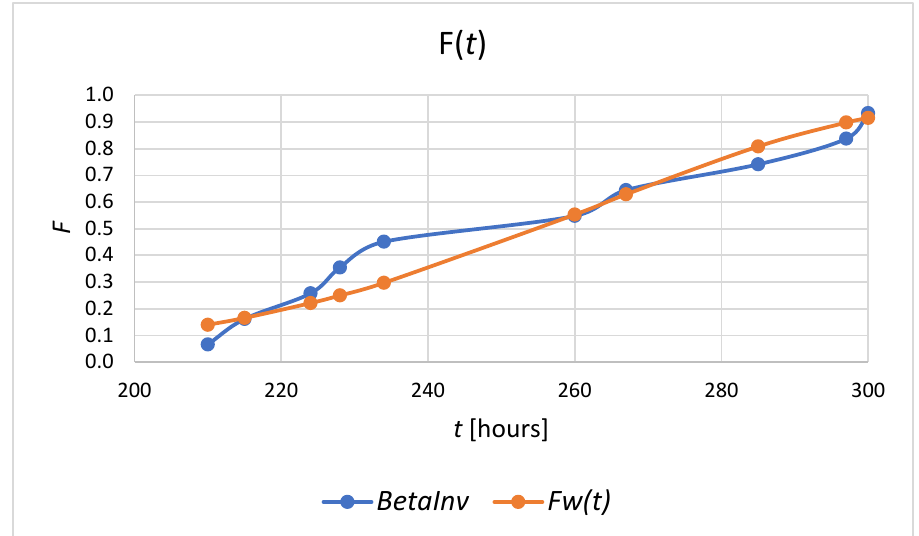
Figure 7. Distribution function graphs F ( t ) that were obtained by the BETA.INV function and by the bi ‐ parametric Weibull model ( γ = 0).